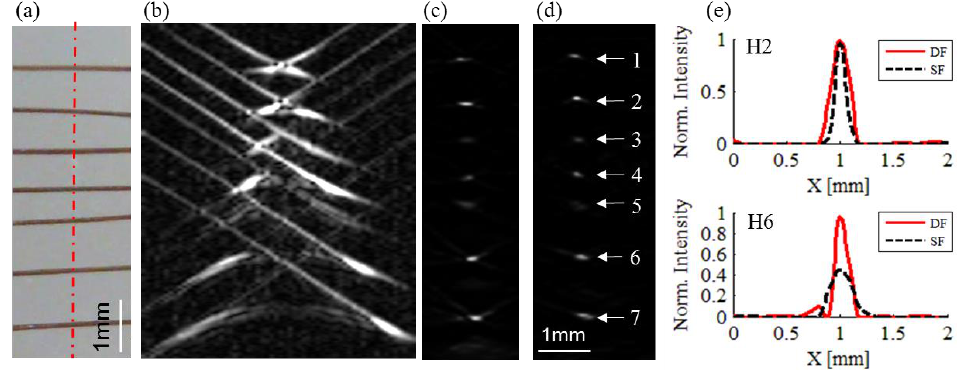
Figure. 3 . Ultrasound field distribution: ( a ) Simulated (top) and measured (bottom) distribution of a dual focused transducer; ( b ) Simulated (top) and measured (bottom) distribution of a single focused transducer.